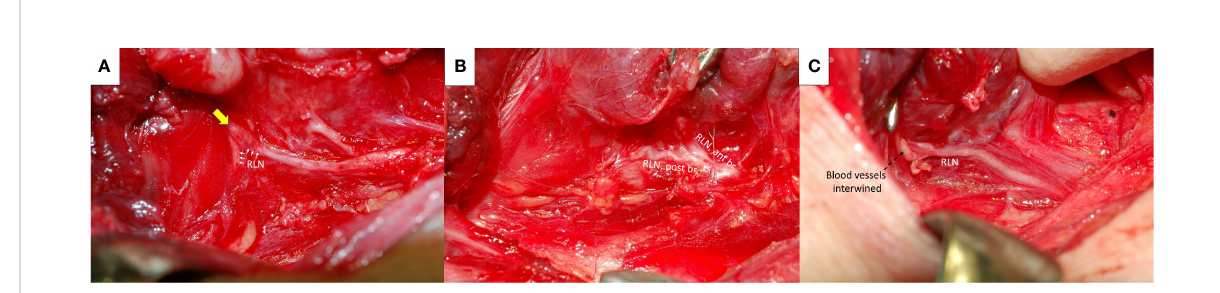
FIGURE 4 Recurrent laryngeal nerve (RLN) and Berry ’ s ligament. The RLN (white arrows) was severely stretched upward at the region of Berry ’ s ligament (yellow arrow) (A) . The anterior motor branch of the RLN penetrates Berry ’ s ligament (B) . A surrounding blood vessel intertwined (black dotted arrows) with the RLN at the region of Berry ’ s ligament (C) . ant br., anterior branch; post br., posterior